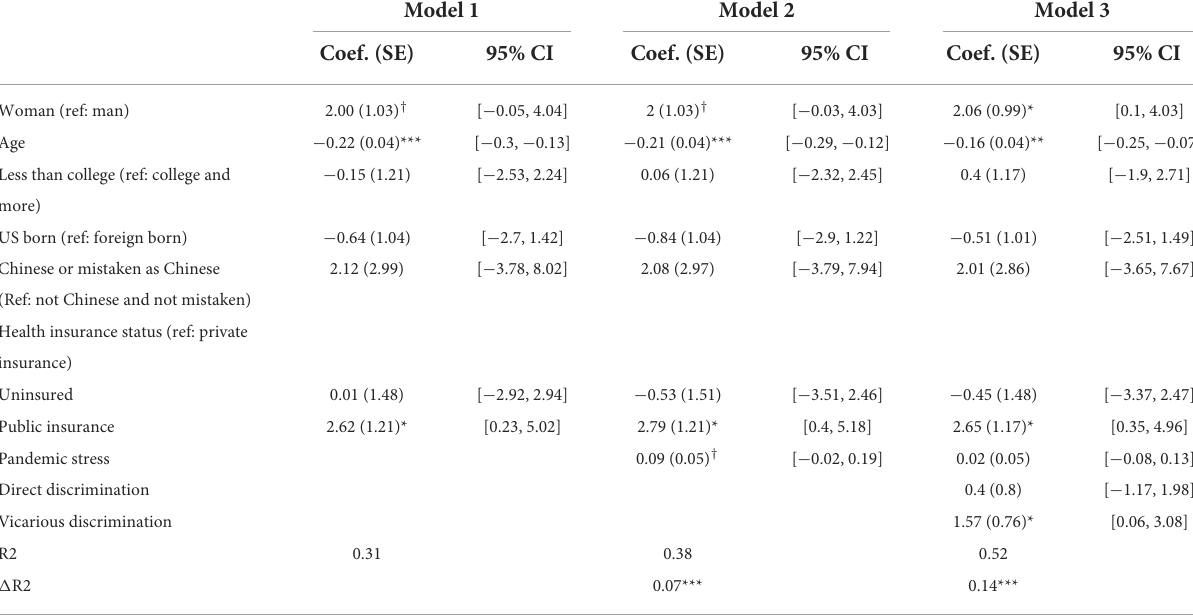
TABLE 9 Hierarchical regressions for psychological worry: Southeast